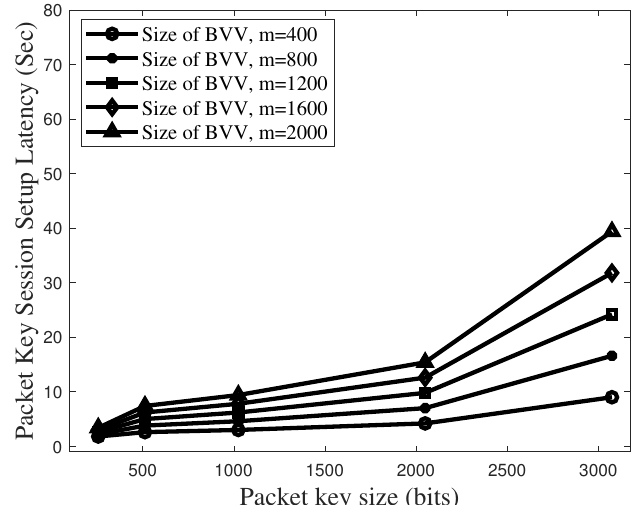
Figure 14. Total latency to set up a packet key-based secure session in the BSM